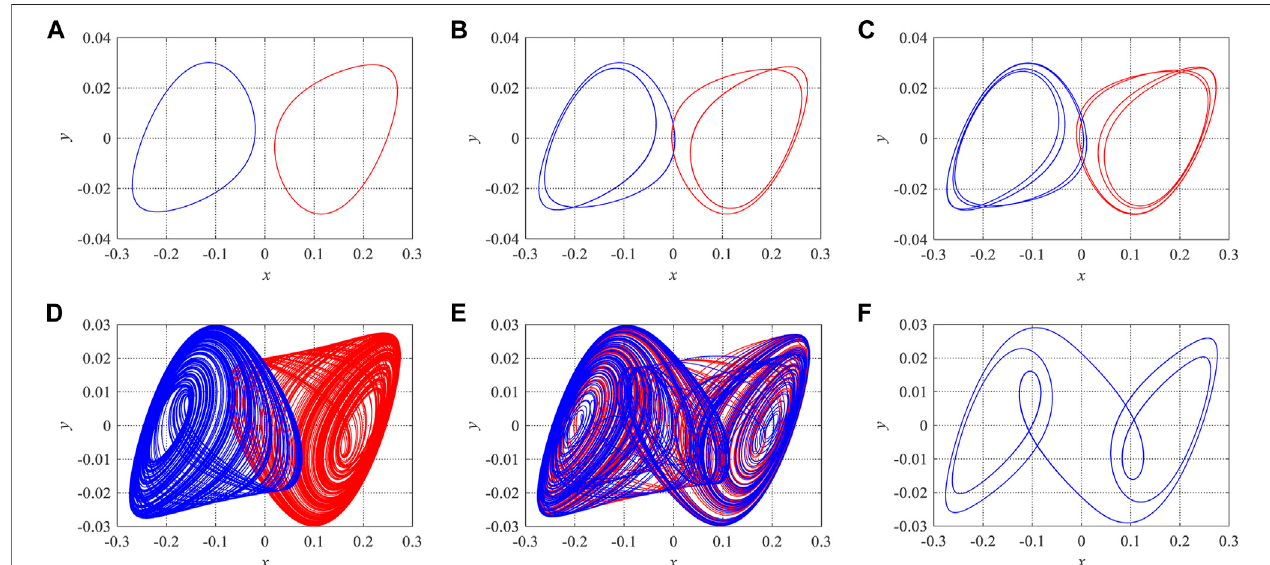
FIGURE 3 | Phase diagram of the modi fi ed Chua ’ s system with different values of the parameter α , the red attractor with initial condition [ x 0 , y 0 , z 0 ] (cid:1) 0 . 01 , 0 , 0 . 01 and blue attractor with initial condition [ x 0 , y 0 , z 0 ] (cid:1) [ − 0.01, 0, − 0.01]. (A) α (cid:1) 60, (B) α (cid:1) 63, (C) α (cid:1) 63.8, (D) α (cid:1) 69, (E) α (cid:1) 72, (F) α (cid:1) 75.